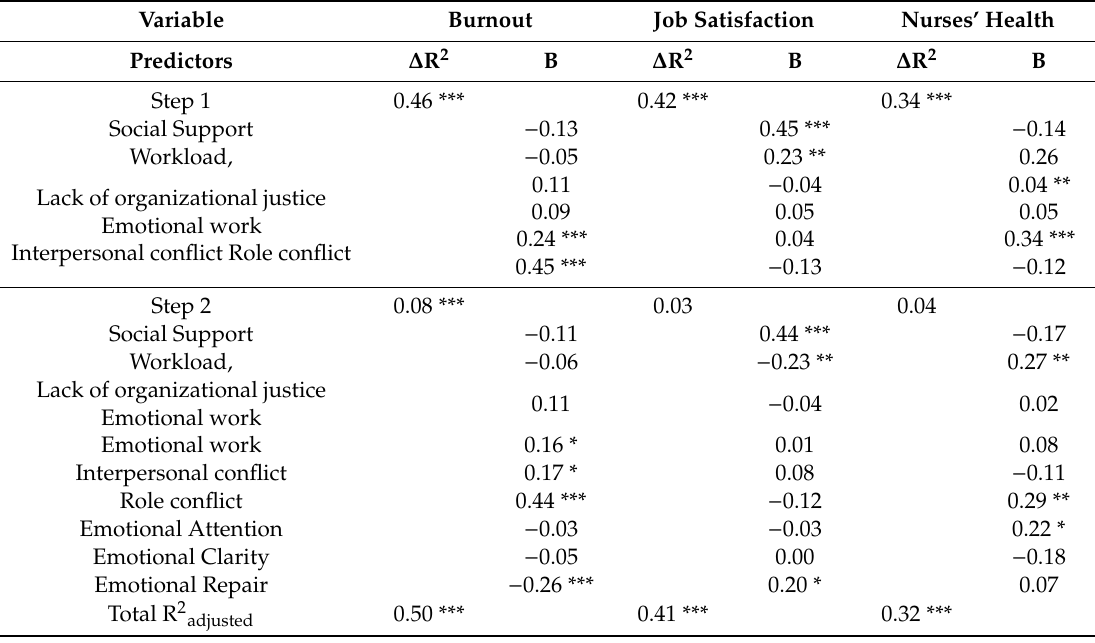
Table 1. Hierarchical regression models based on emotional intelligence and psychosocial risks on burnout, job satisfaction, and nurses’